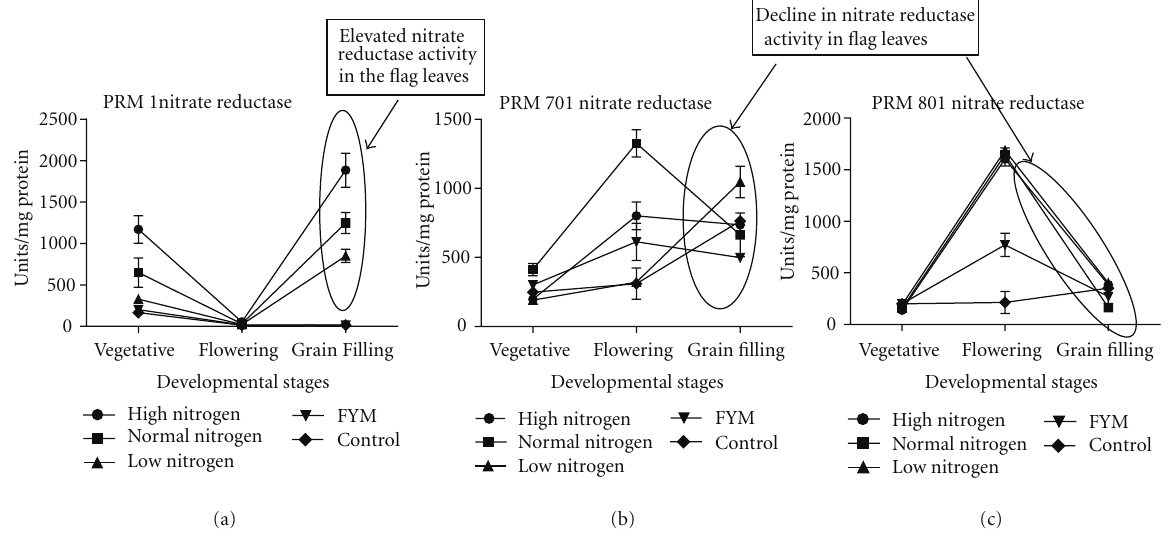
Figure 2: Influence of nitrogen fertilization on nitrate reductase (NR) enzyme activity (specific activity) at various developmental stages of finger millet genotypes (a) brown PRM-1, (b) golden PRM-701, (c) white PRM-801.